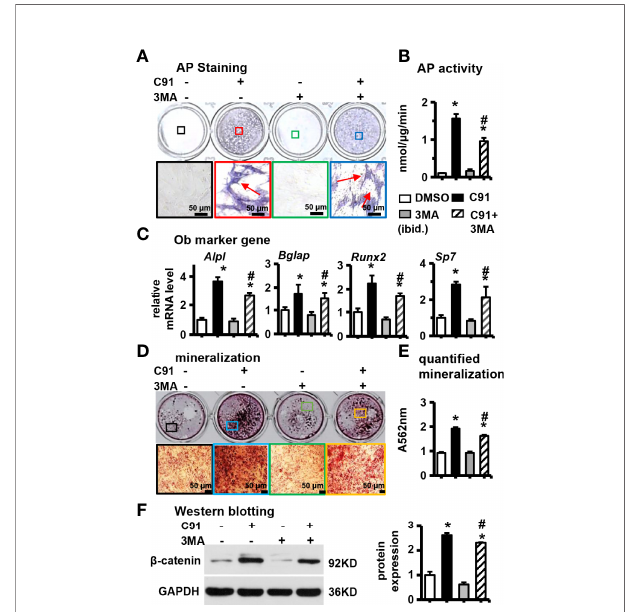
FIGURE 5 | Effects of inhibition of autophagy on ST2 cell differentiation. 3MA is an inhibitor of autophagy. Before ST2 cells were treated with C91, they were pre-treated with autophagy inhibitor 3MA (5 mM) for 6 hours. The samples were collected for AP staining (A) analysis and AP biochemical quantitative (B) analysis. The bottom panel is 10× magni fi cation of the upper panel, red arrows are alkaline phosphatase-positive cells, scale bar = 50 m m. (C) qRT-PCR analysis results. (D) ST2 cells were pre-treated with autophagy inhibitor 3MA for 6 hours, and then ST2 cells were treated with C91 for 14 days, and the osteogenic induction medium was changed every two days. Alizarin red S staining was used to detect mineralized nodules. The lower image is a 10× enlargement of the upper image. Scale bar = 50 m m. (E) is the quantitative analysis result of panel (D, F) The expression of protein b -catenin was detected by Western blot, and the bar on the right is the quantitative result of the band on the left. Results are expressed as mean ± SD (n = 3 per group). * P <0.05, compared to the DMSO group. # P <0.05, compared to the C91